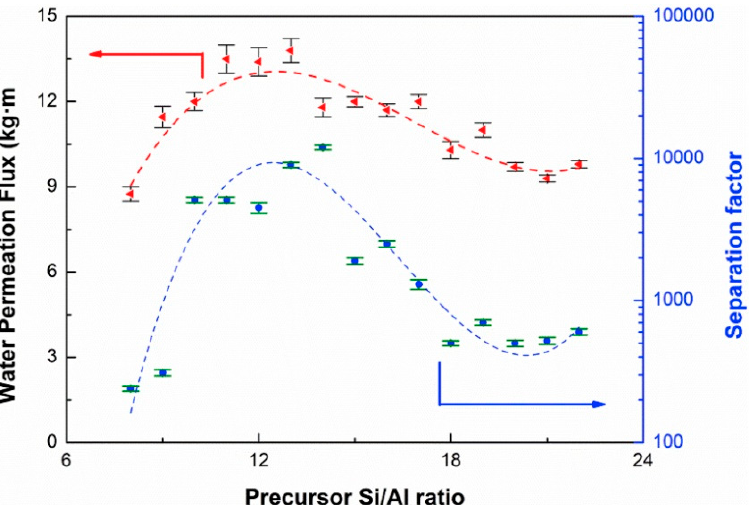
Figure 2. Effect of precursor Si/Al ratio of CHA zeolite membranes for ethanol dehydration (10 wt.% water, at 75 °C). Reproduced with permission from [39]; published by Elsevier, 2019. License number 5010730294396.